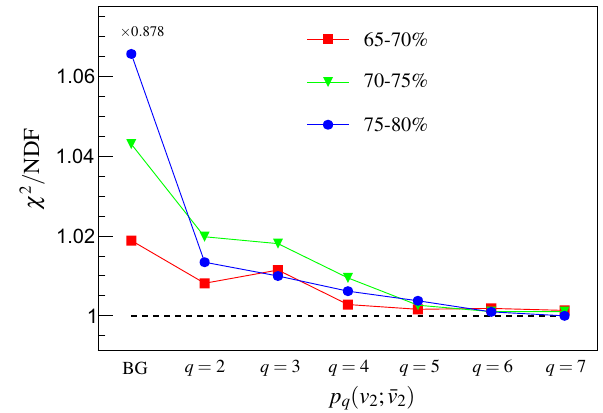
Fig. 2 Examining the accuracy of the Gram–Charlier A series with the actual distribution obtained from simulation by studying χ 2 /